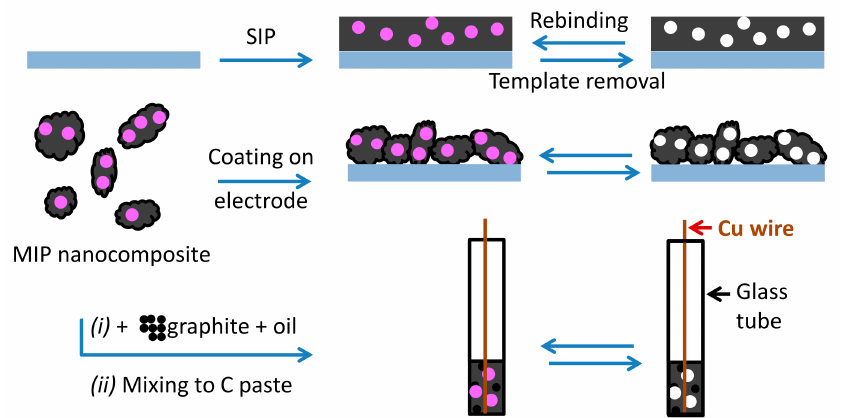
Figure 6. Three main methods to prepare MIP-based electrodes for electrochemical sensors, by direct surface initiated polymerization (SIP) on the electrode chemical ( top ), by preparation of MIP nanocomposite and coating it on the electrode surface ( middle ), and by preparing carbon paste electrode (CPE) using a mixture of MIP and carbon powders in mineral oil. MIP designates pure im- printed polymer or its corresponding composite containing nanostructures (clay, carbon, nanometal . . . ). For the sake of simplicity, MIP means either a molecular, ion or pathogen-imprinted